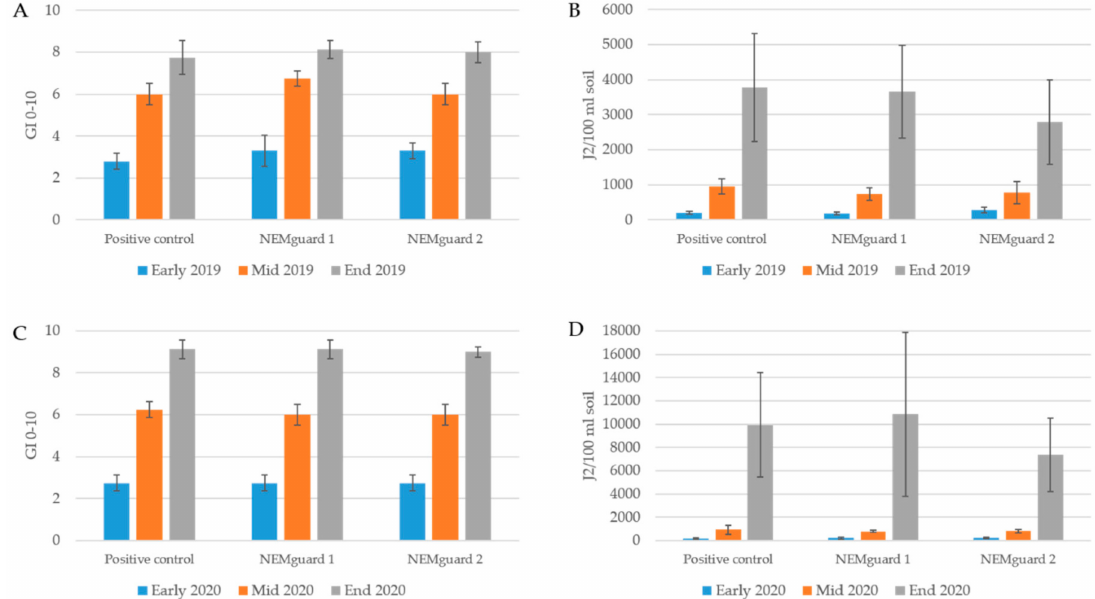
Figure 2. Tomato root gall formation ( A , C ) and Meloidogyne incognita juvenile second stage (J2) soil population ( B , D ) development in the large-scale greenhouse trial over 10 (early), 15 (mid) and 23 (end) weeks testing NEMguard ® DE applied before planting (NEMguard 1) and applied before planting followed by a monthly application (NEMguard 2). Suspensions containing approximately 4600 (2019) or 4500 (2020) M. incognita eggs/J2 were inoculated per pot. Values for the gall index (GI) according to Zeck [25] and J2 populations are means of n = 4 (early and mid) and n = 8 (end), respectively. No significant difference according to one-way ANOVA with post-hoc Tukey HSD test among the treatments and the positive control ( p ≤ 0.05). Positive (p) control = control with M. incognita , negative (n) control = soil free of M. incognita.